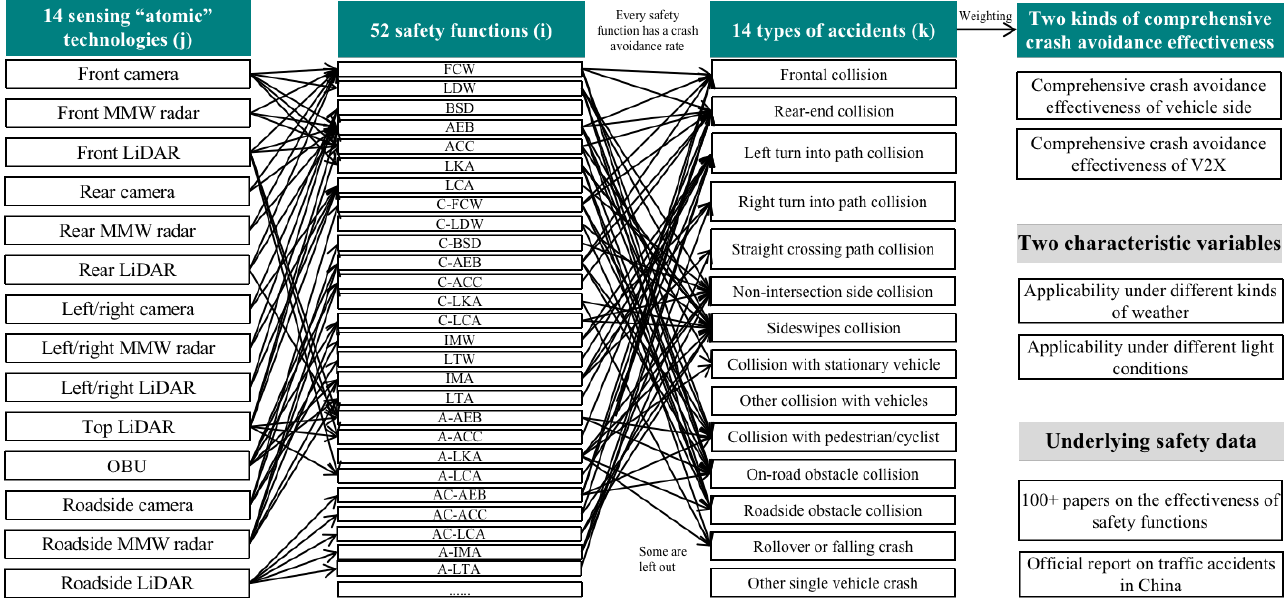
Figure 2. Details of the multivariable coupling model: “Atomic” technology, safety function, accident type, and crash avoidance effectiveness.